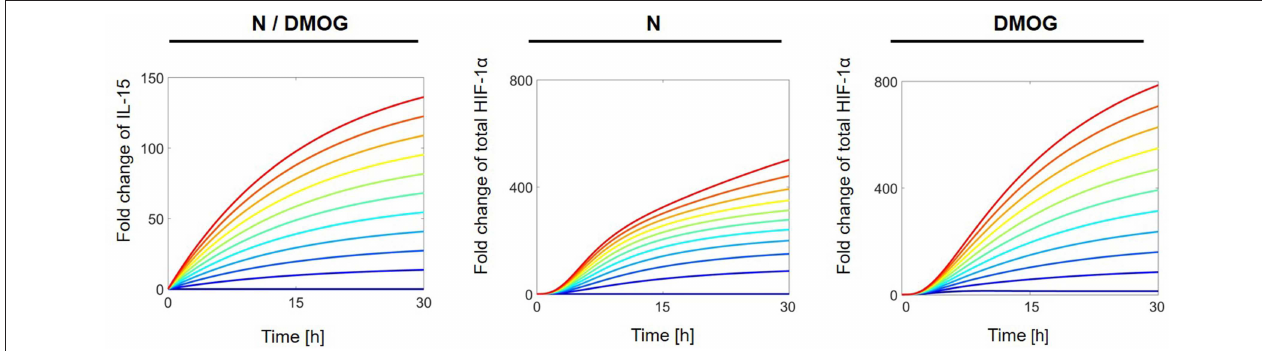
FIGURE 6 | Effects of external IL-15 regulation on total HIF-1 α in NK cells cultivated in the absence (N) or presence of DMOG. External IL-15 regulation rate ( a 1 ) is varied in [0,10] nM h − 1 with regular steps. Other parameters and initial values are fixed as in Tables 1 , 2 . Curves with same color correspond to the same parameter value and follow the jet color map in MATLAB ® , with dark blue corresponding to the lowest value ( a 1 = 0 nM h − 1 ) and red to the highest value ( a 1 = 10 nM h − 1 ). Left: IL-15 dynamics is equal in both, NK cells cultivated without and with DMOG as there is no feedback on IL-15 in the model (cf. Equation 2); middle: Total HIF-1 α in untreated NK cells; right: Total HIF-1 α in NK cells cultivated with DMOG.